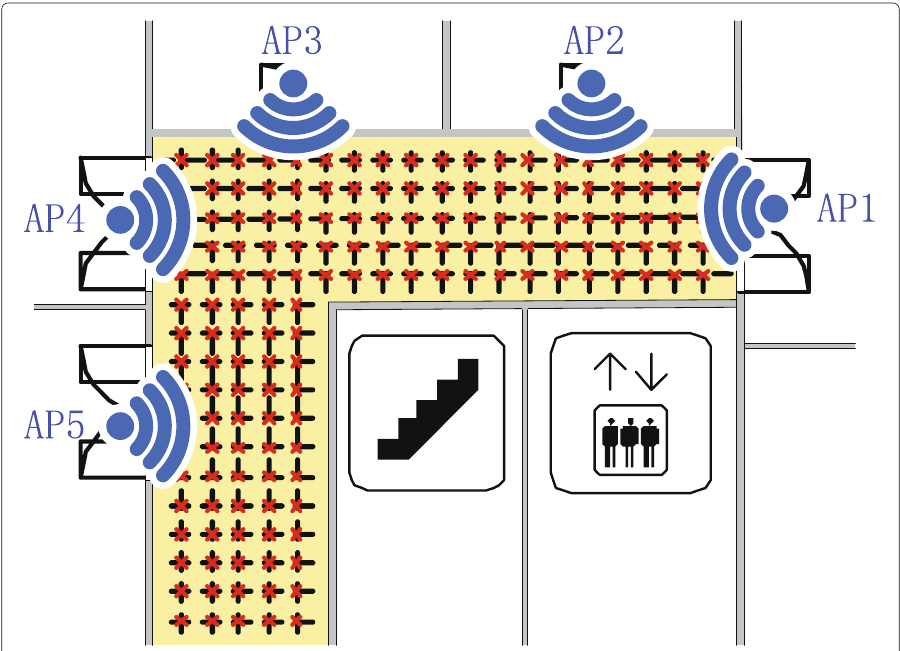
Fig. 11 Illustration of reference points distribution in the interesting area for